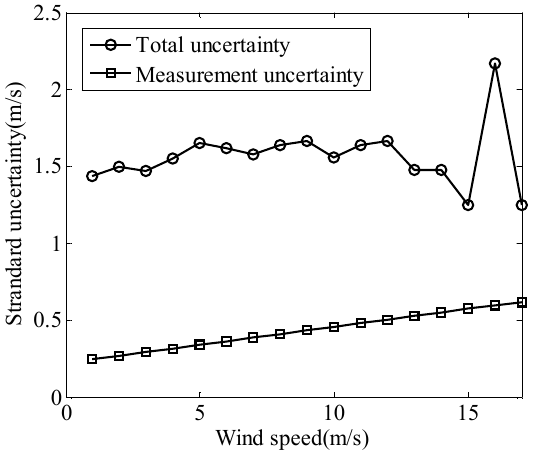
Figure 15. Combined and measurement uncertainty in this case.